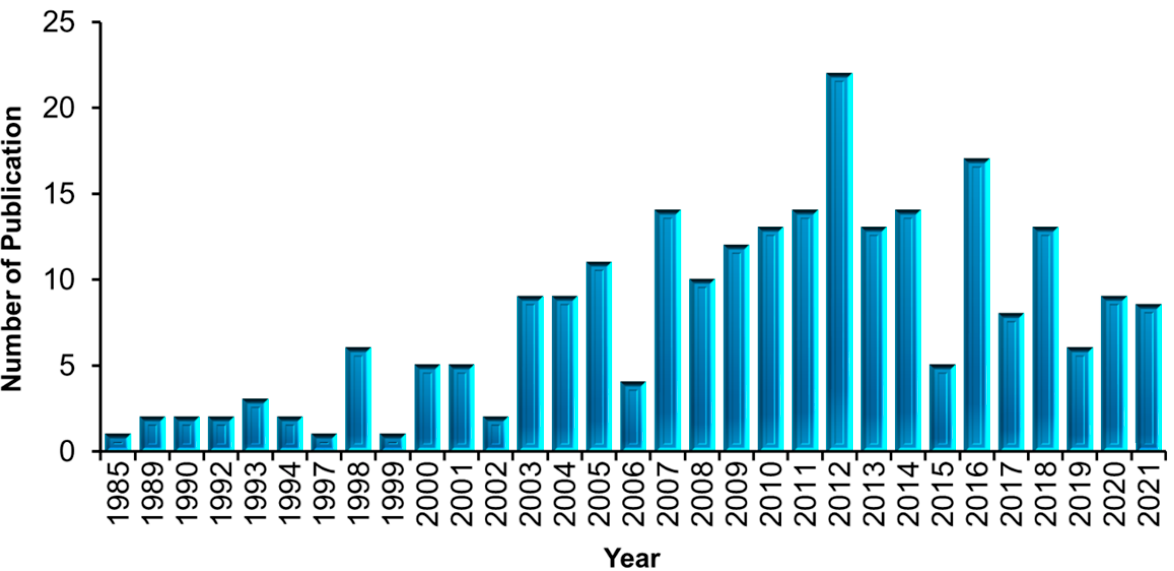
Figure 5. Frequency of publications on FPBMs prepared by RIGC per year in the period of 1985–